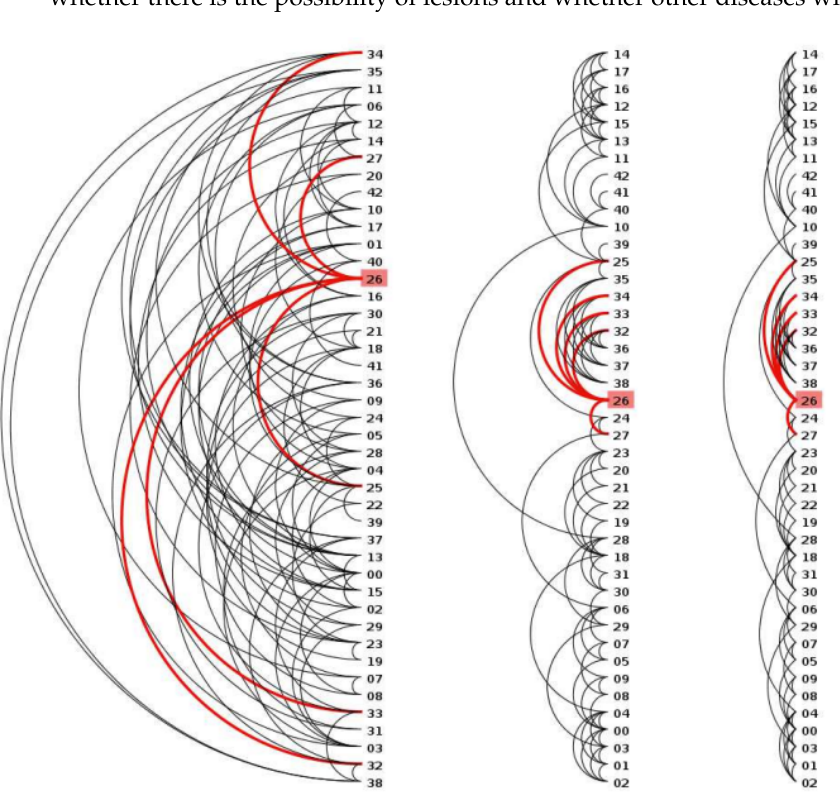
Figure 14. Circular arc layout [60]. Arc diagrams of a 43-node, 80-edge network: left: with a random ordering and 180-degree arcs; middle: after applying the barycenter heuristic to order the nodes; right: after changing the angles of the arcs to 100